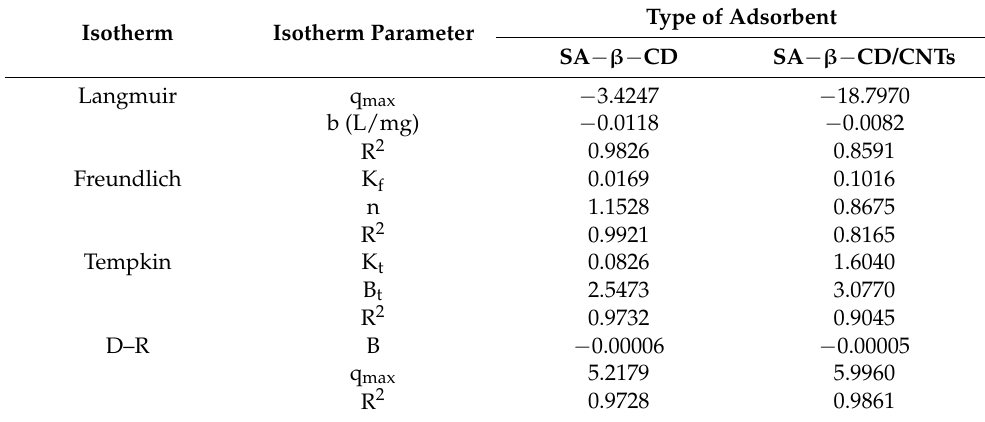
Table 2. Isotherm